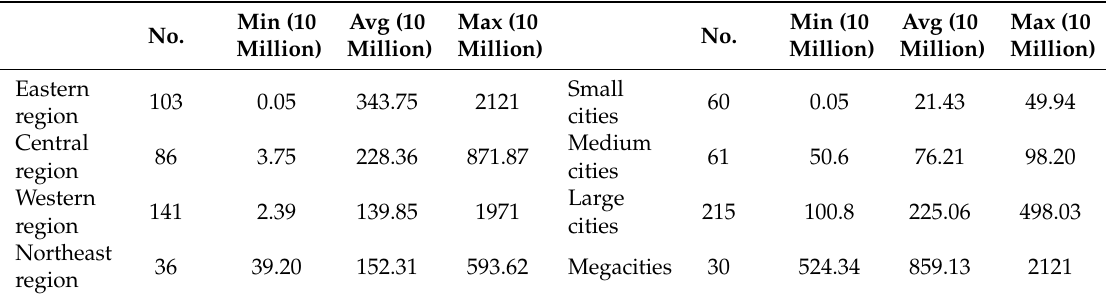
Table 2. Description of populations in di ff erent cities.